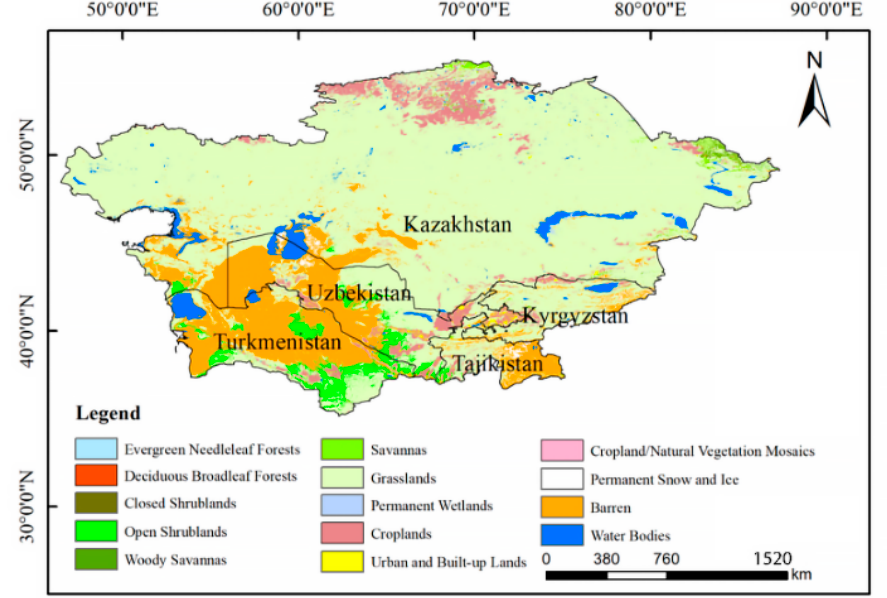
Figure 1. Map of study area. The land cover data was adapted from 500 m Moderate Resolution Imaging Spectroradiometer (MODIS) land cover product (MCD12Q1).